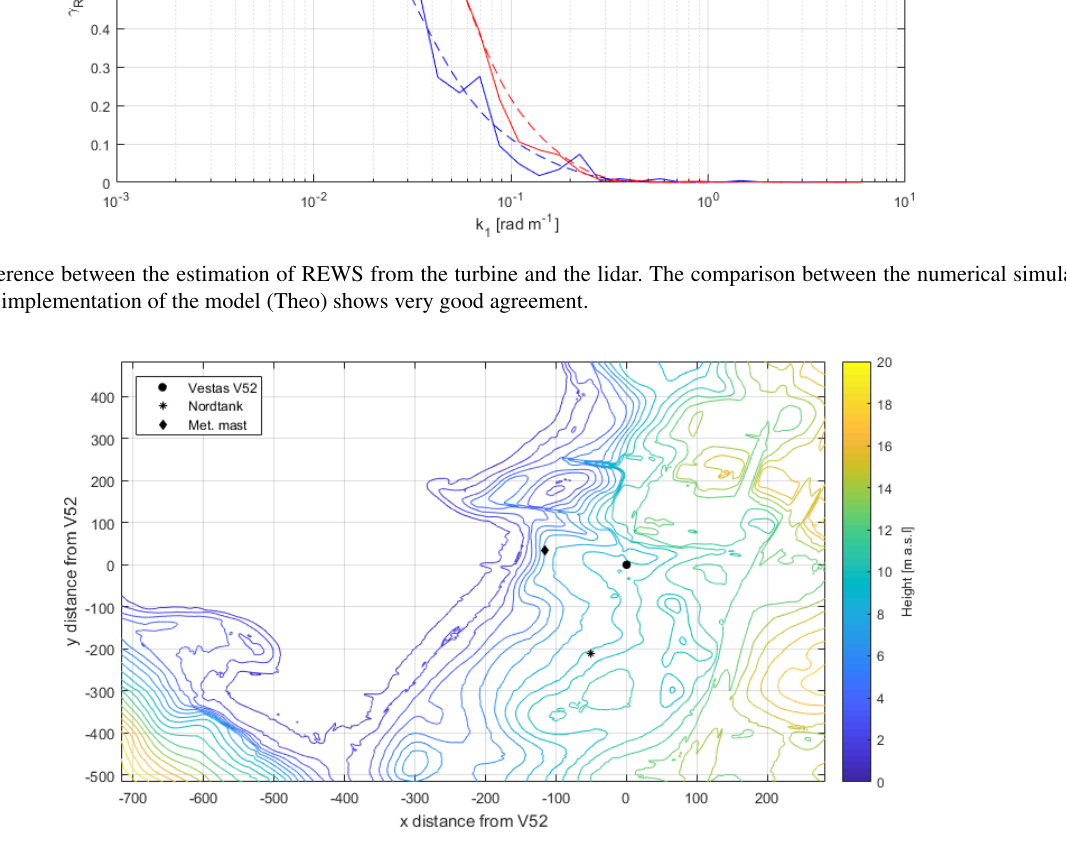
Figure 3. Digital terrain model (DTM) of the DTU’s test site at Risø, where the Vestas V52, its meteorological mast and the Nordtank turbine are indicated. Zone 32 UTM coordinates centred at the Vestas V52 turbine were used. The DTM data were obtained from the Danish Map Supply (Agency for Data Supply and Efficiency, 2018). The units on both axes are in